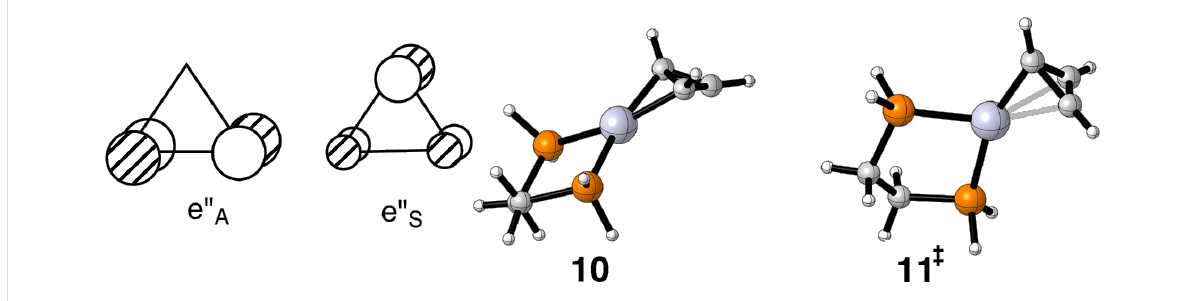
Figure 3: The empty degenerate set of π orbitals in the cyclopropenium cation is shown on the left side. On the right are the two optimized structures of C 3 H 3 –Pt(dpe) + .